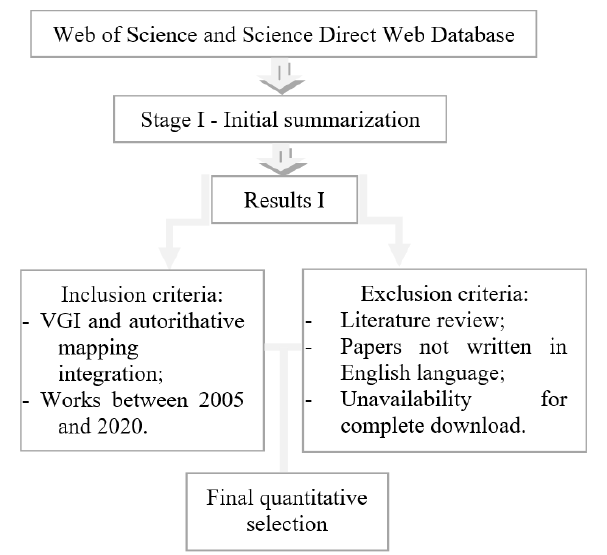
Figure 1: Criteria used for research selection.